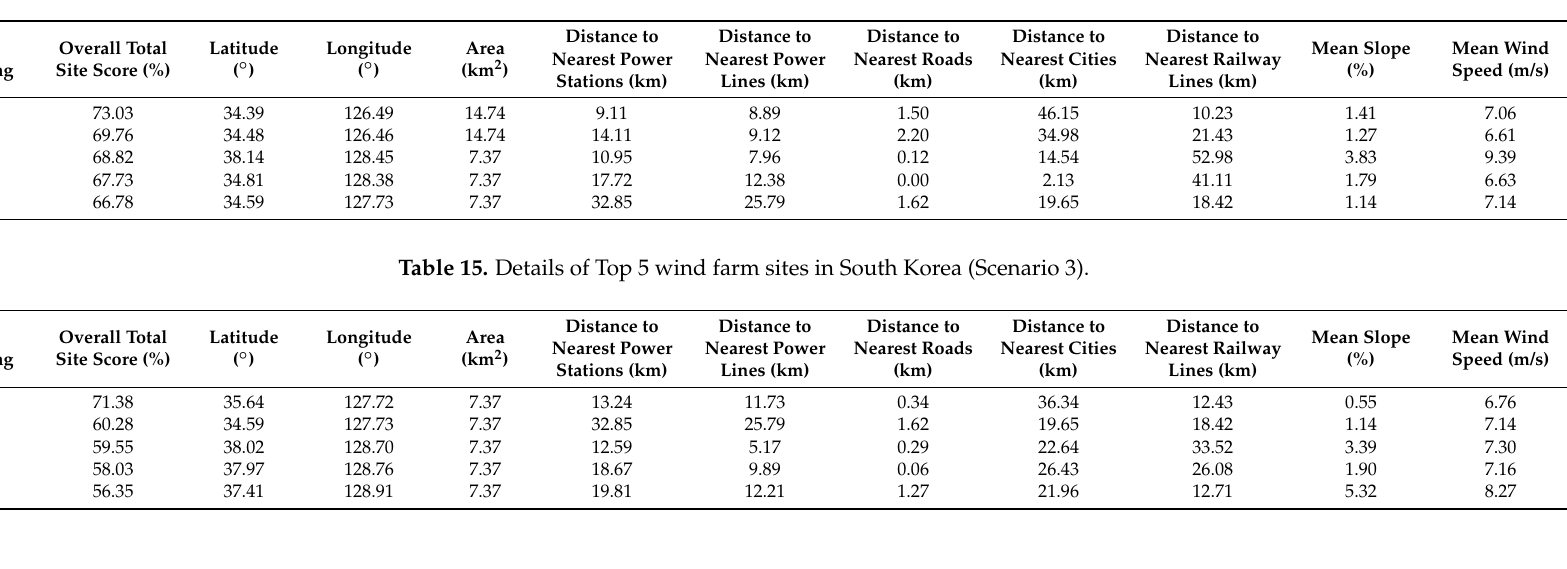
Table 14. Details of Top 5 wind farm sites in South Korea (Scenario 2).